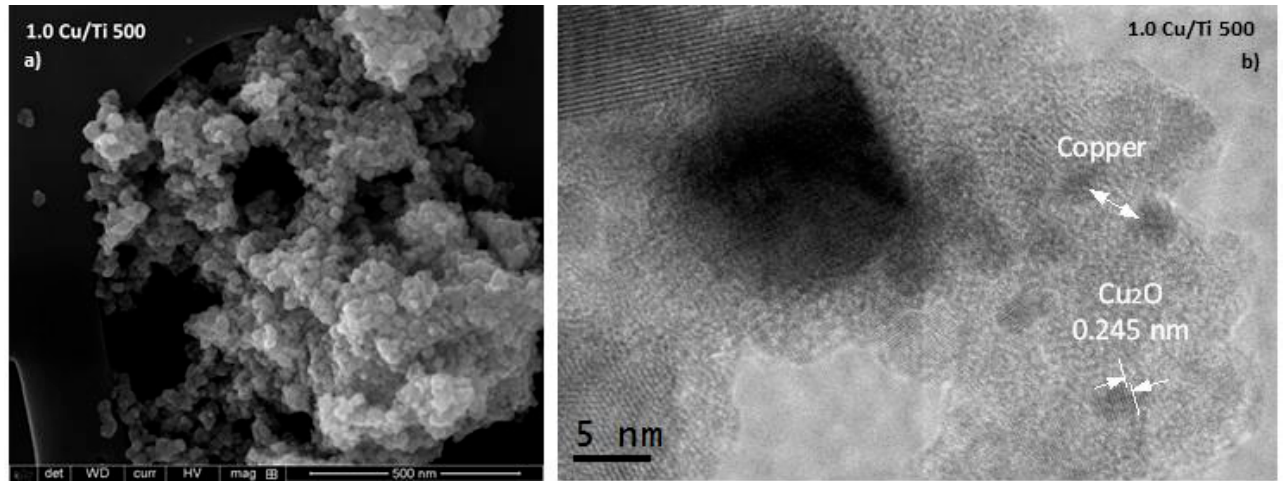
Figure 2. ( a ) SEM image, ( b ) TEM image for the 1.0 Cu/Ti 500 photocatalyst. The copper content was measured by X-ray Fluorescence technique, see Table 1. For 1.0 Cu/Ti sample, the experimental copper content corresponds to 0.95 wt.%. For